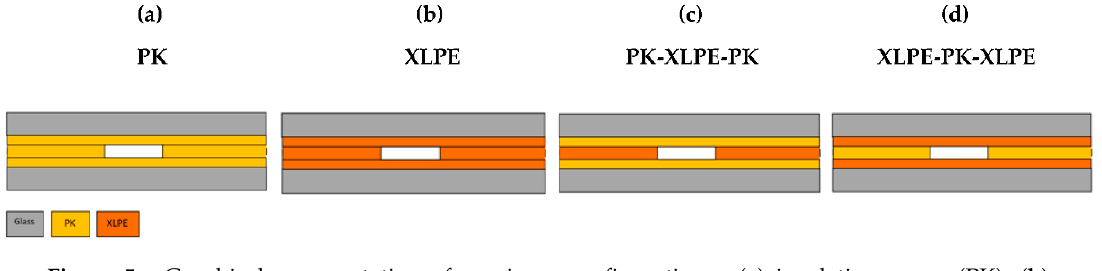
Figure 5. Graphical representation of specimen configurations: ( a ) insulating paper (PK), ( b ) polyethylene (XPLE), ( c ) top/bottom insulating paper, void layer XLPE, ( d ) top/bottom XLPE, void layer PK.